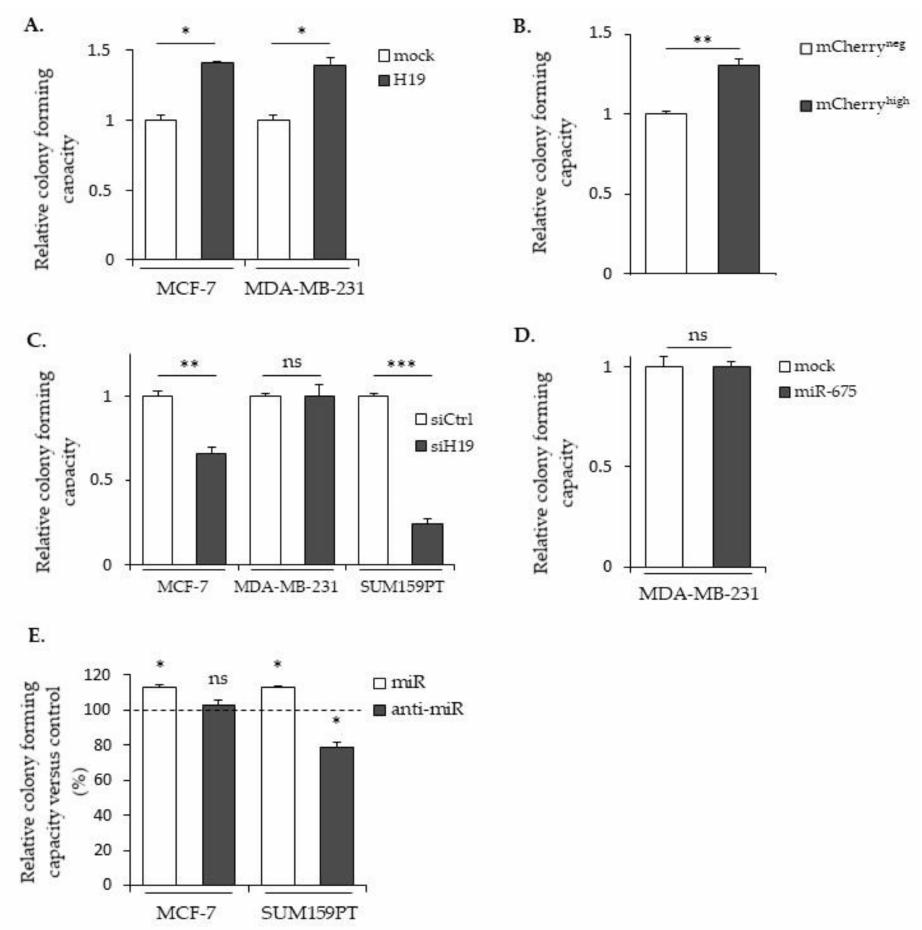
Figure 5. E ff ects of H19 and miR-675 in colony formations. ( A ) The clonogenic capacities of the control (mock) or H19 -overexpressing cells (H19). ( B ) The relative clonogenic capacities of SUM159PT-pH19-mCherry neg versus SUM159PT-pH19-mCherry high . ( C ) The clonogenic capacities of the control (siCtrl) and H19 -knockdown cells (siH19). ( D ) The clonogenic capacities of the MDA-MB-231 control (mock) or miR-675-overexpressing cells (miR-675). ( E ) The clonogenic capacities of the miR-675-transfected cells (miR) or miR-675-specific inhibitor transfected cells (anti-miR). Results are presented as a percentage of the control. * p < 0.05; ** p < 0.01; *** p < 0.001; ns: not